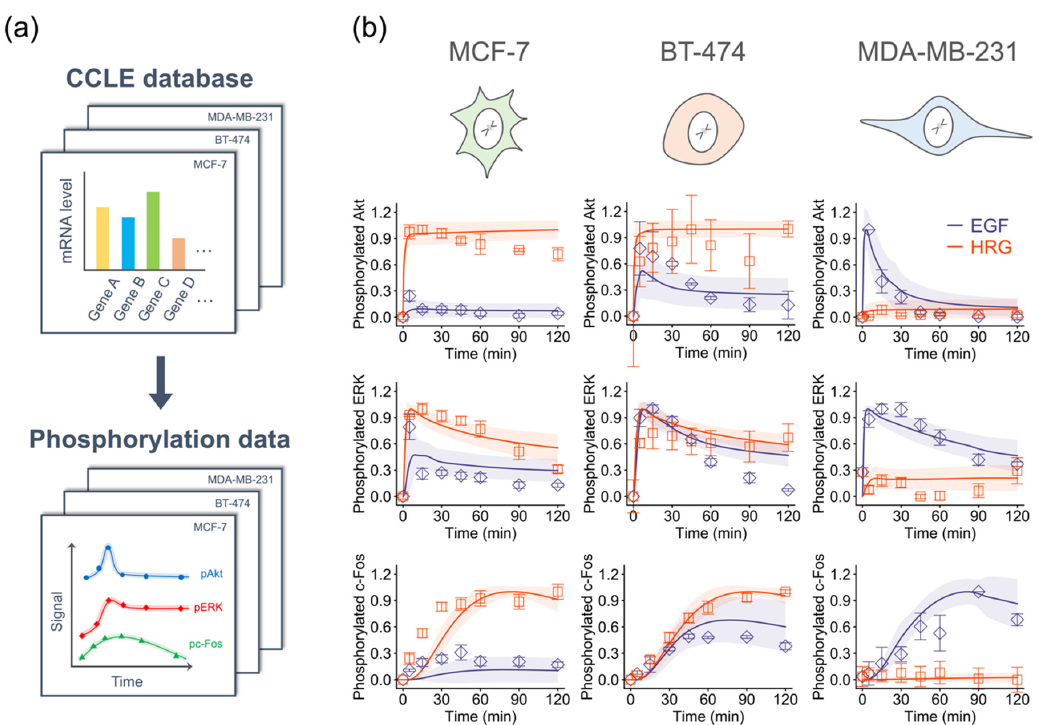
Figure 3. Parameter training against experimental datasets. ( a ) Overview of the parameterization procedure. ( b ) Results of parameter estimation. Points: (Blue diamonds, EGF; red squares, HRG) denote experimental data and lines denote the averaged simulation results of 30 parameters, and shaded areas indicate standard deviation. For all panels, error bars denote standard error for three independent experiments. The Western blot images can be found in Figure S1.